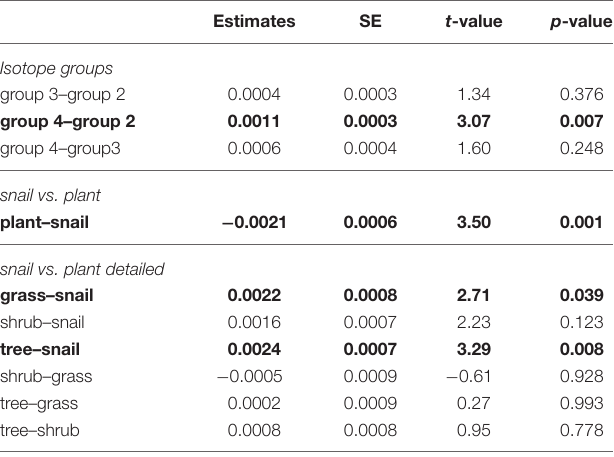
TABLE 3 | Post-hoc Tukey’s HSD test for variables for which robust Levene tests identified a significant difference in the variability of the 87 Sr/ 86 Sr sample values between groups. Estimates SE t -value p